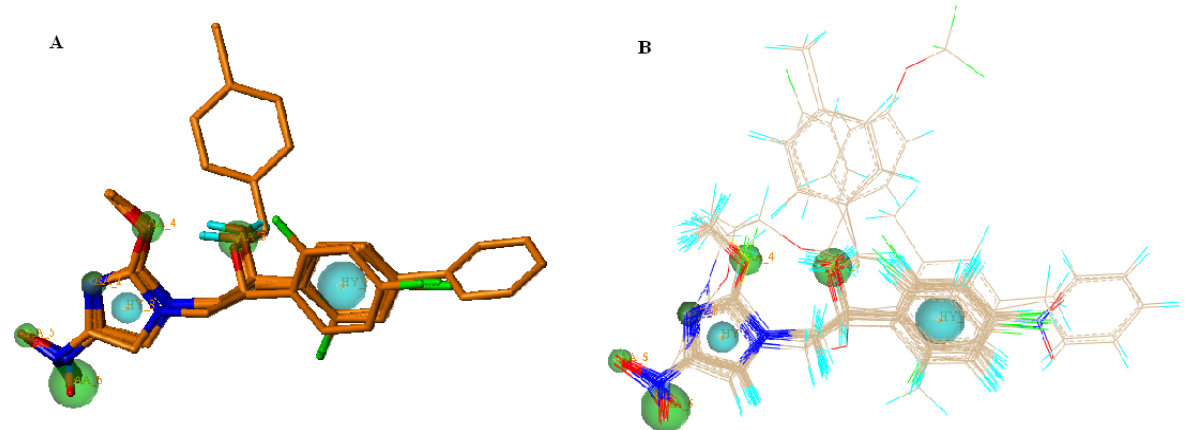
Figure 3. Selected pharmacophore model M_02 ( A ) and molecular alignment ( B ) of the nitroimidazole compounds used to elaborate the model: Cyan, hydrophobes; Green, HB acceptors; Magenta, HB